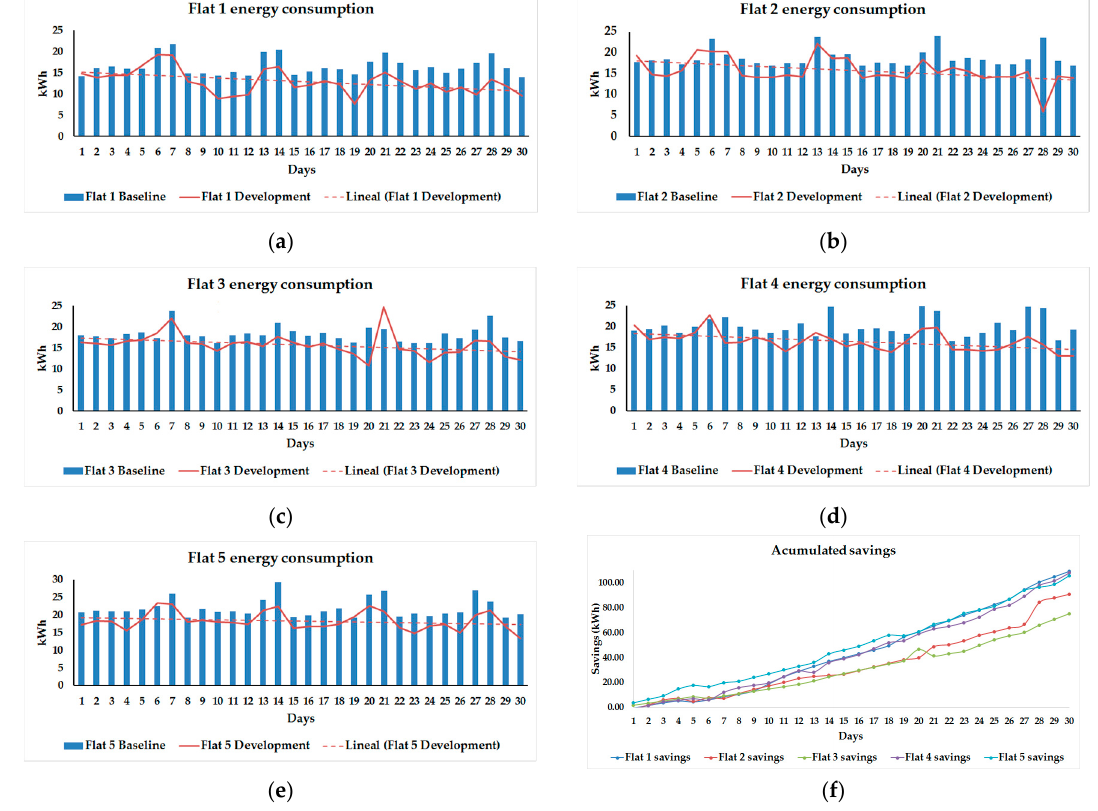
Figure 9. Daily energy consumption during the baseline and the experimentation periods in each flat ( a – e ); and accumulated savings ( f ). The results demonstrate the reduction in consumption and the lineal tendency shows how players acquire good habits along the experimentation. Table 2. Results of the Student’s t -test and Levene’s test performed to assess the difference of means and variances between the baseline usage data and the data collected during the experimentation. All the flats present a lower percentage of energy usage after the